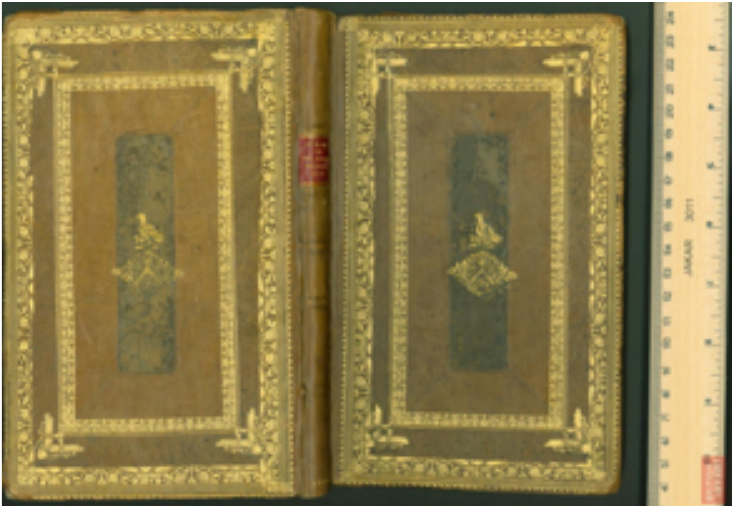
Fig. 42. Upper and lower cover, Hiram or the grand master-key (London: W. Griffin, in Fetter-Lane, and T. Toft, in Chelmsford, 1764). BL,